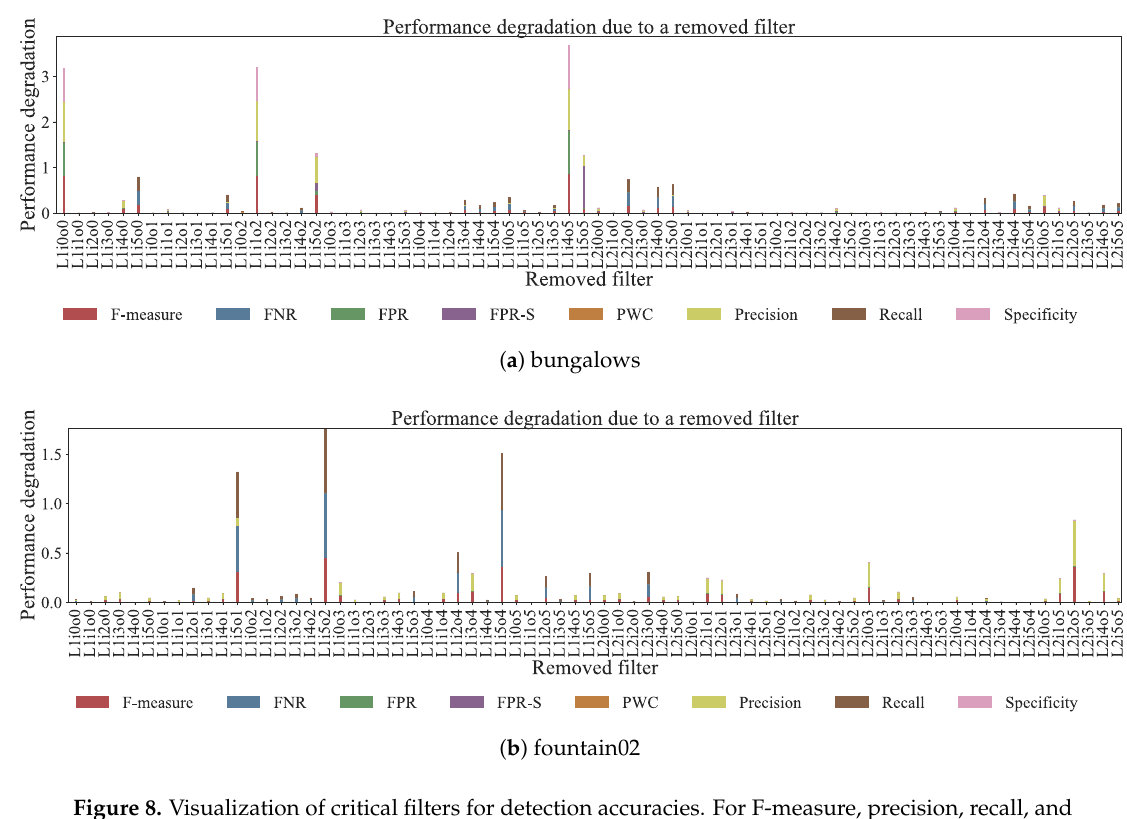
Figure 8. Visualization of critical filters for detection accuracies. For F-measure, precision, recall, and specificity, performance degradation increases when the metrics decrease after removing a filter. In FNR, FPR, FPR-S, and PWC, performance degradation increases when the metrics increase after removing a filter. Filters with the higher performance degradation value is more critical for detection accuracies. The name of removed filters denotes a layer, input channel, and output channel. For example,